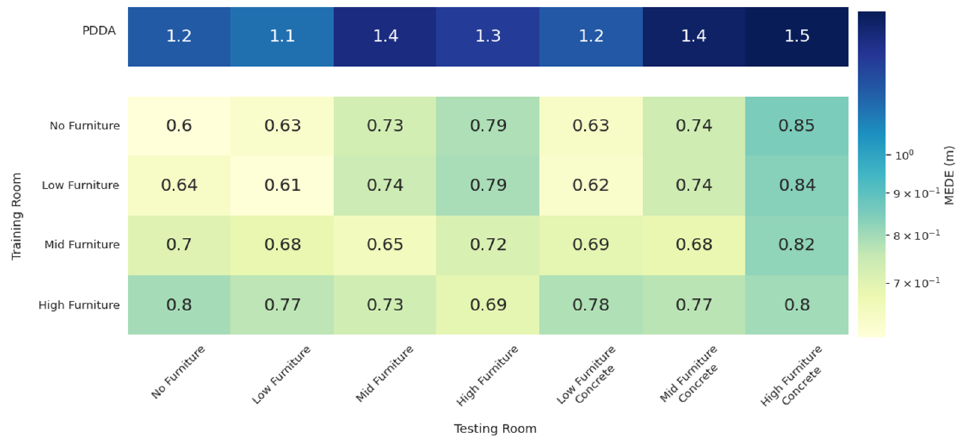
Figure 7. MEDE of the CNN-based joint model on different rooms. PDDA methods performance in